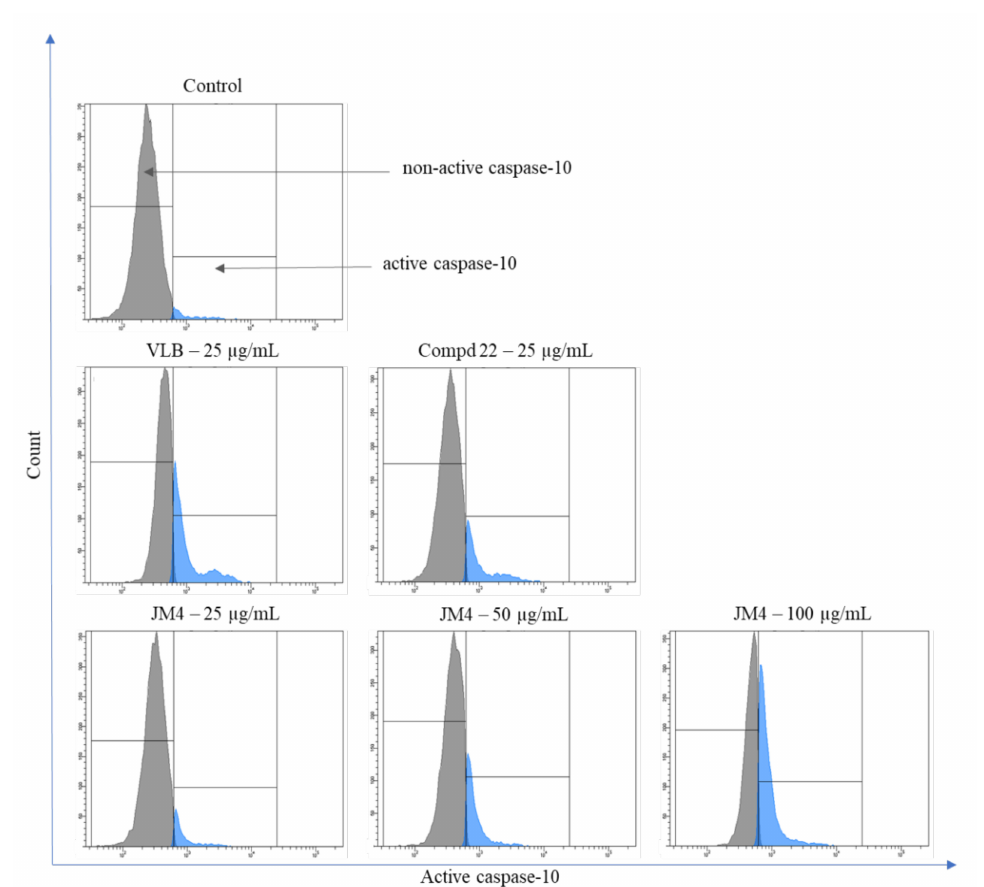
Figure 17. Flow cytometric analysis of populations C32 melanoma cells treated for 24 h with JM4 (25, 50, 100 µ g/mL), 22